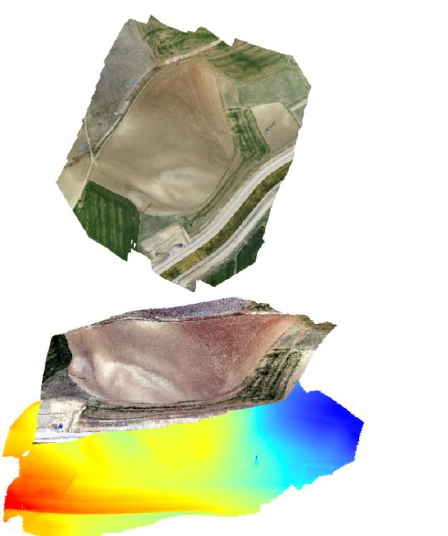
Figure 6. Generated DSM and ortophoto by using UAV